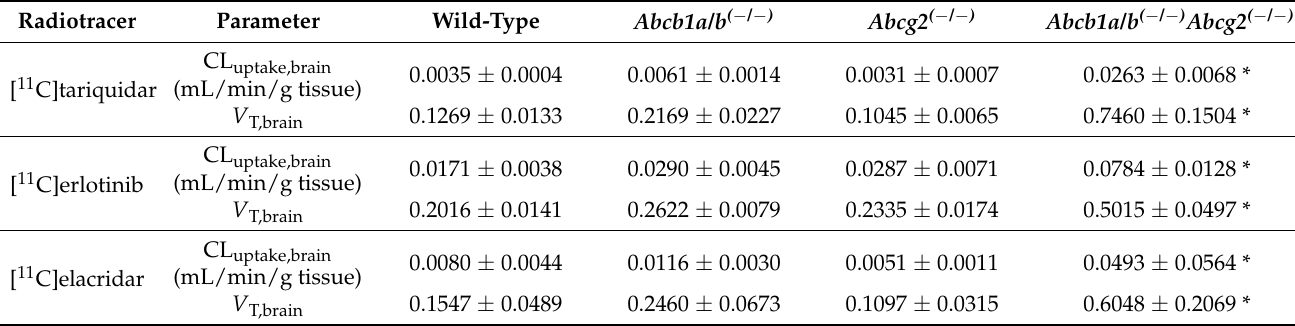
Table 1. PK parameters obtained with graphical non-compartmental analysis describing the brain distribution of [ 11 C]tariquidar, [ 11 C]erlotinib, and [ 11 C]elacridar in wild-type, Abcb1a/b ( − / − ) , Abcg2 ( − / − ) , and Abcb1a/b ( − / − ) Abcg2 ( − / − )